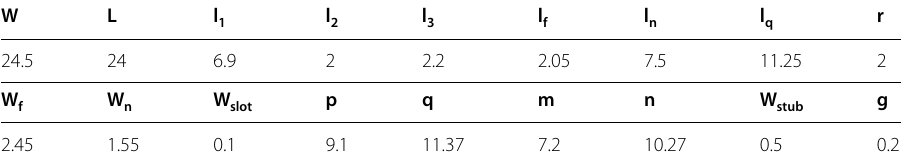
Table 1 Key parameters of the proposed antenna (unit: mm) W